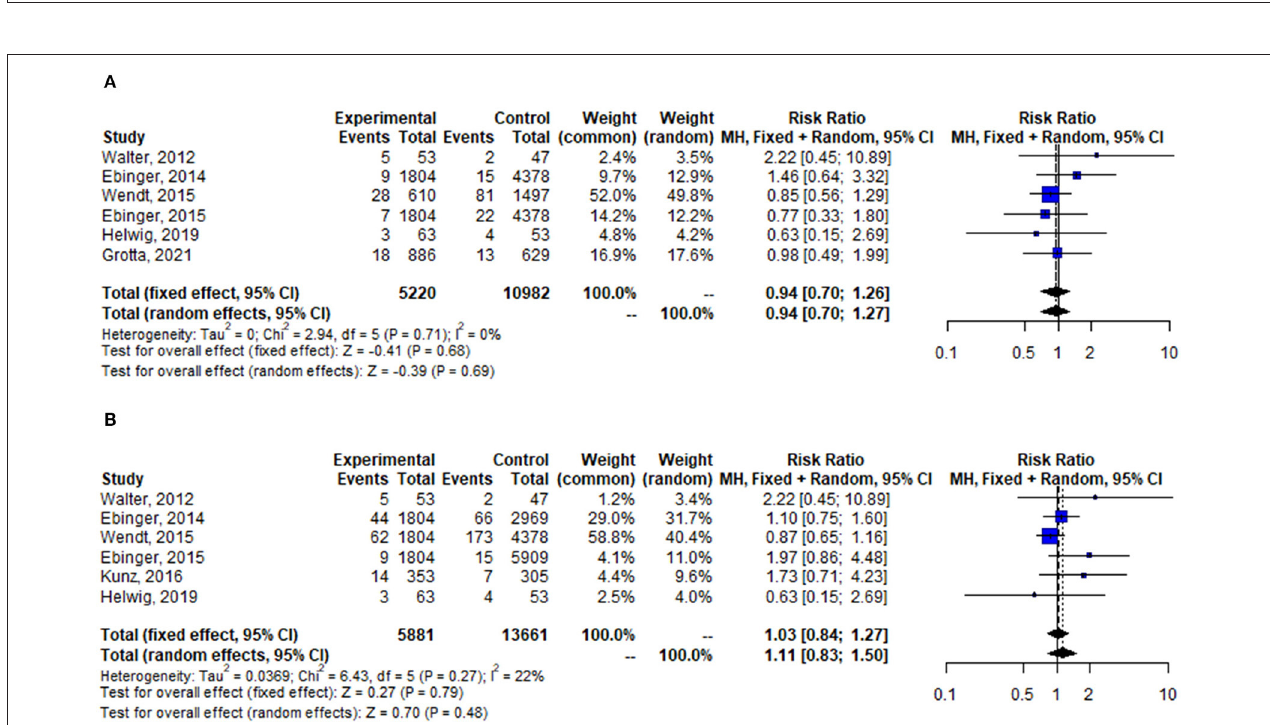
FIGURE 4 | Forest plot for change in stroke-related or neurological events (A) , and in-hospital mortality (B) .